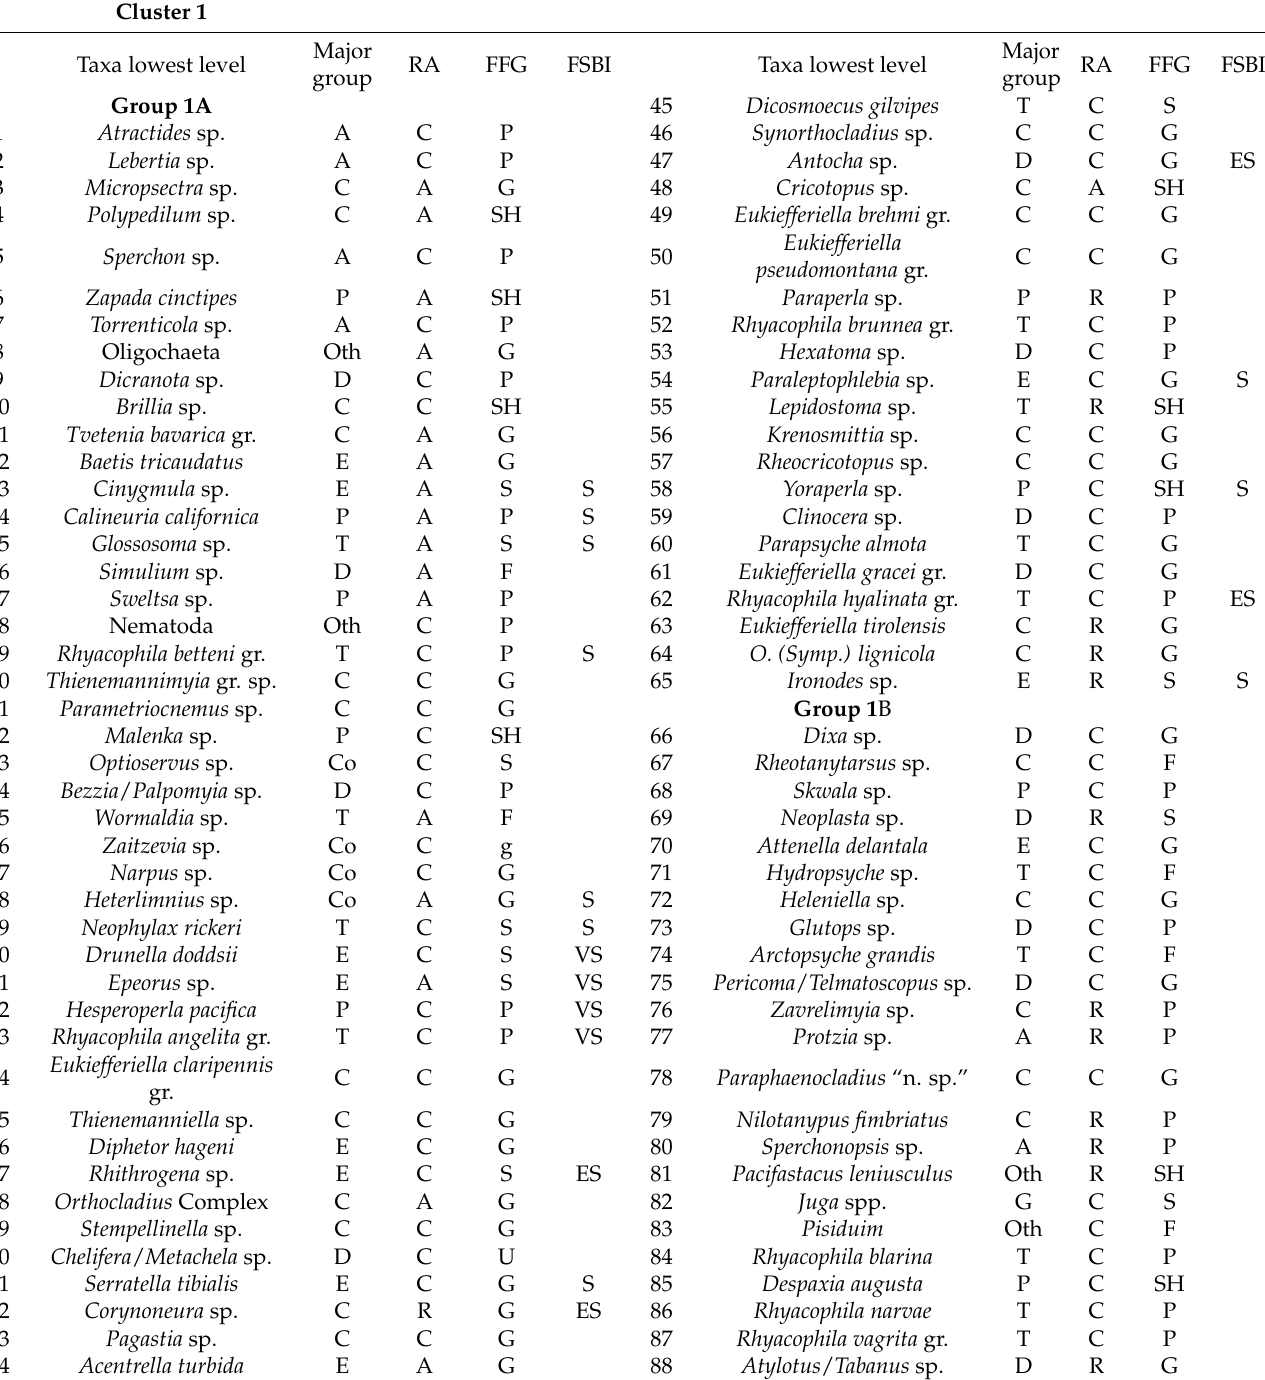
Table 3. List of all taxa collected classified in Cluster 1 and Cluster 2. Relative abundances (RA) are A—abundant > 1% of all collections, C—common between 0.01 and 1%, and Rare < 0.01%. Major taxonomic groupings are: A—Acari,